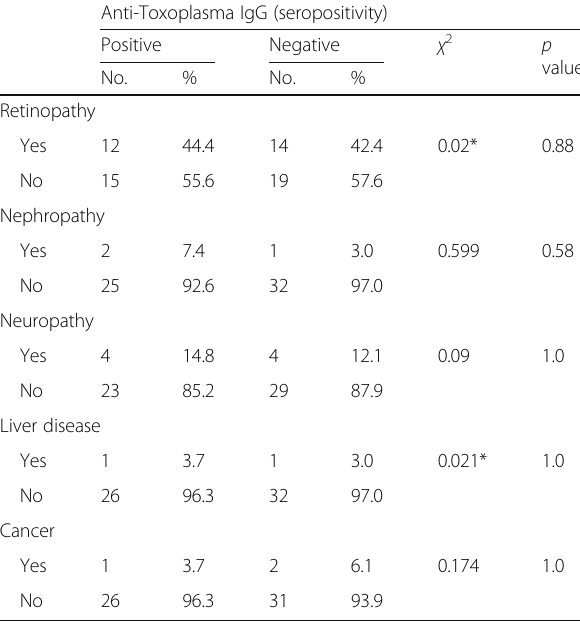
Table 2 Distribution of patients and control groups according to anti-Toxoplasma IgG, IgM, and ANA prevalence